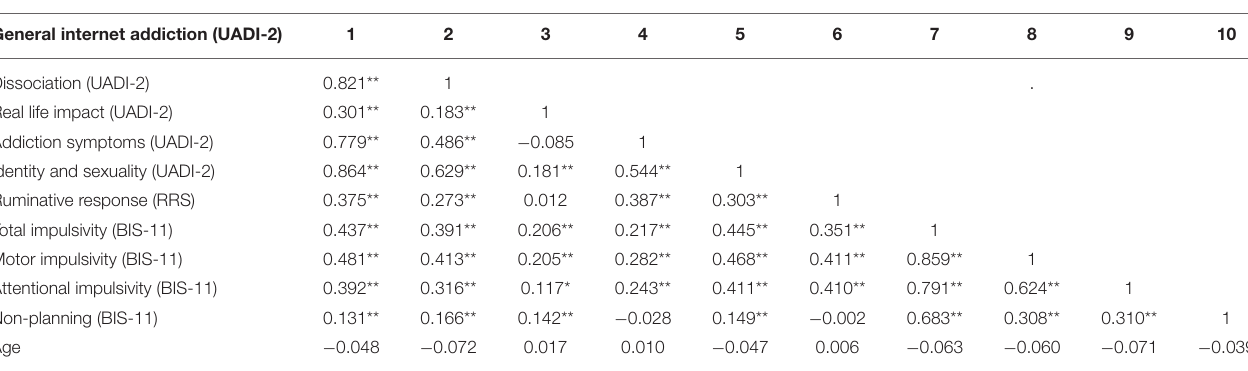
TABLE 4 | Bivariate correlations.